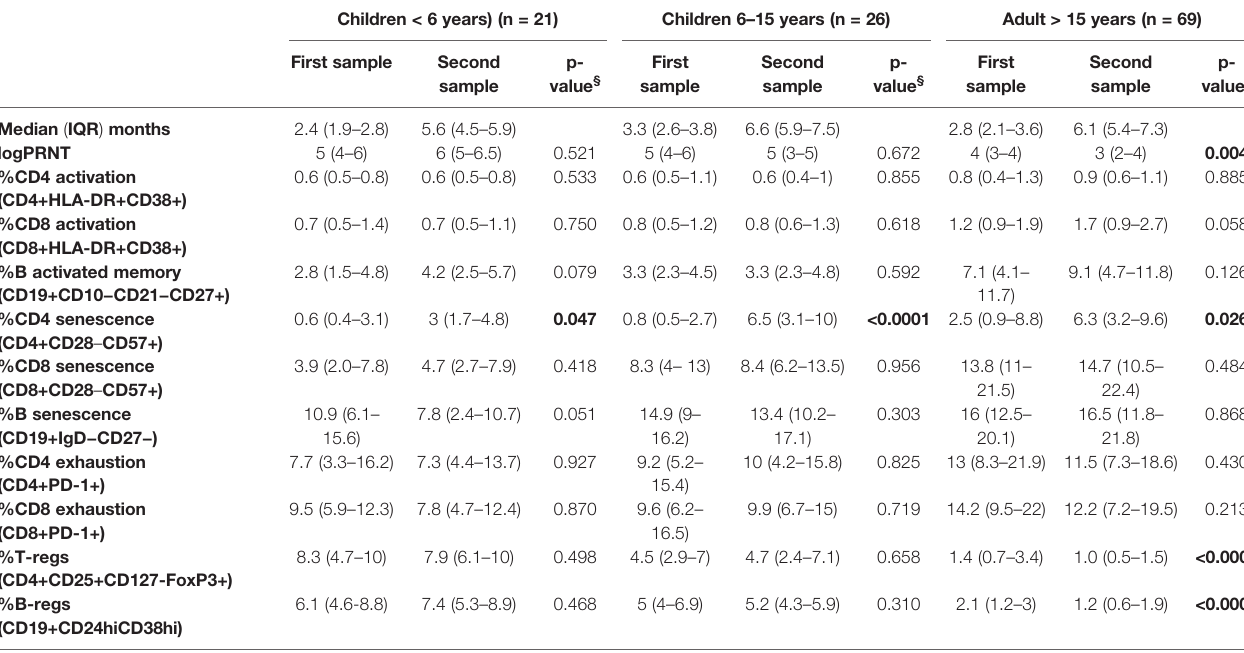
TABLE 4 | Differences of immunological parameters between fi rst and second sampling.